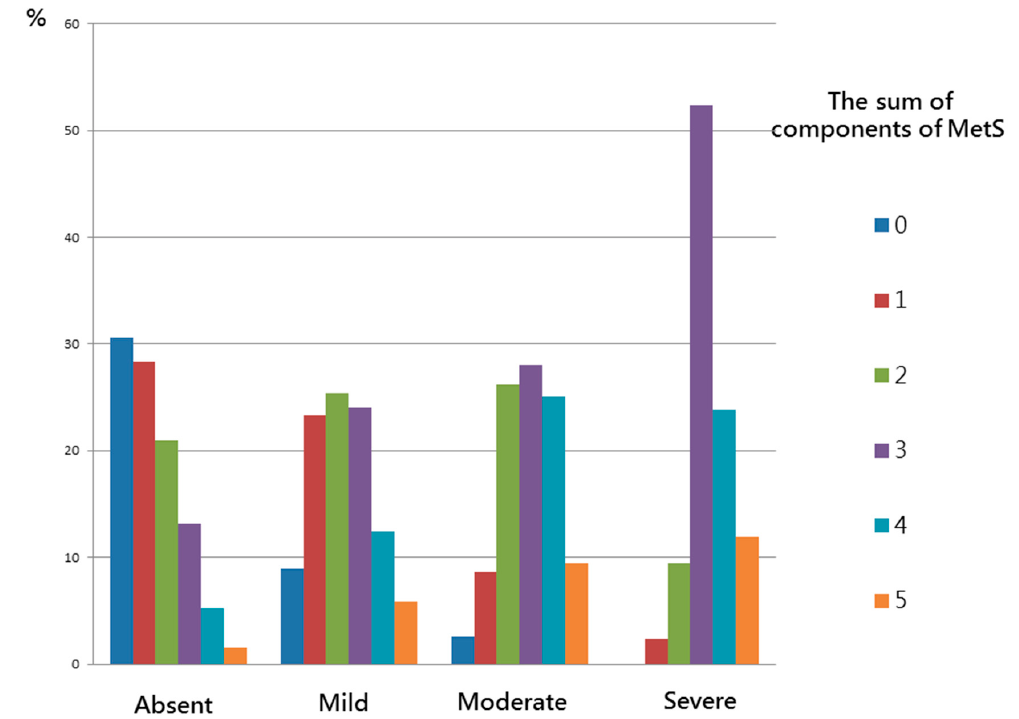
Figure 2. There were significant trends for stepwise increases in the sum of components of MetS corresponding to the severity of NAFLD in study participants.